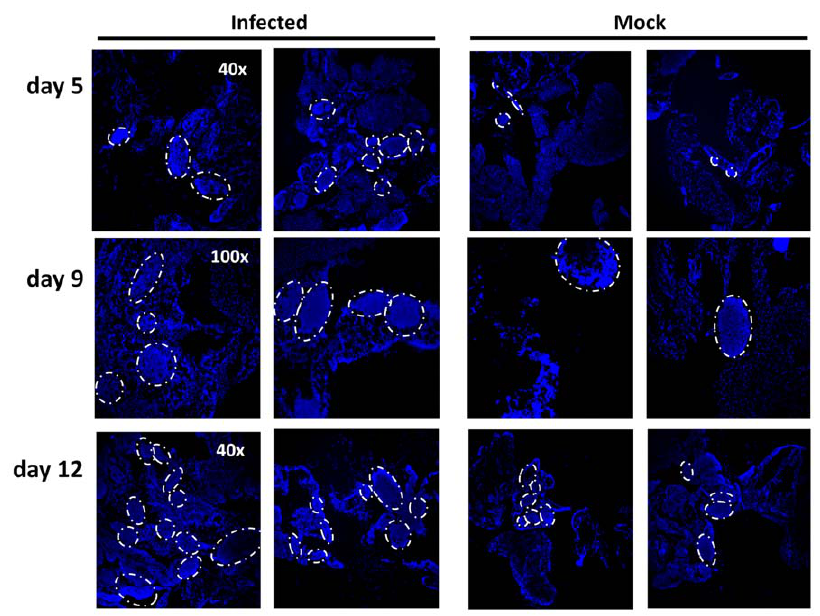
Figure 1. Increased size and frequency of omental immune aggregates in MHV68-infected mice. Omenta from mice inoculated intraperitoneally (i.p.) with 1000 plaque forming units (pfu) virus in complete media (cDMEM) or cDMEM alone (mock) and harvested at the indicated times post infection. Omenta were cryosectioned and stained using DAPI-containing mounting media. Dense DAPI-staining in immune aggregates, ‘‘milky spots,’’ is outlined by dashed